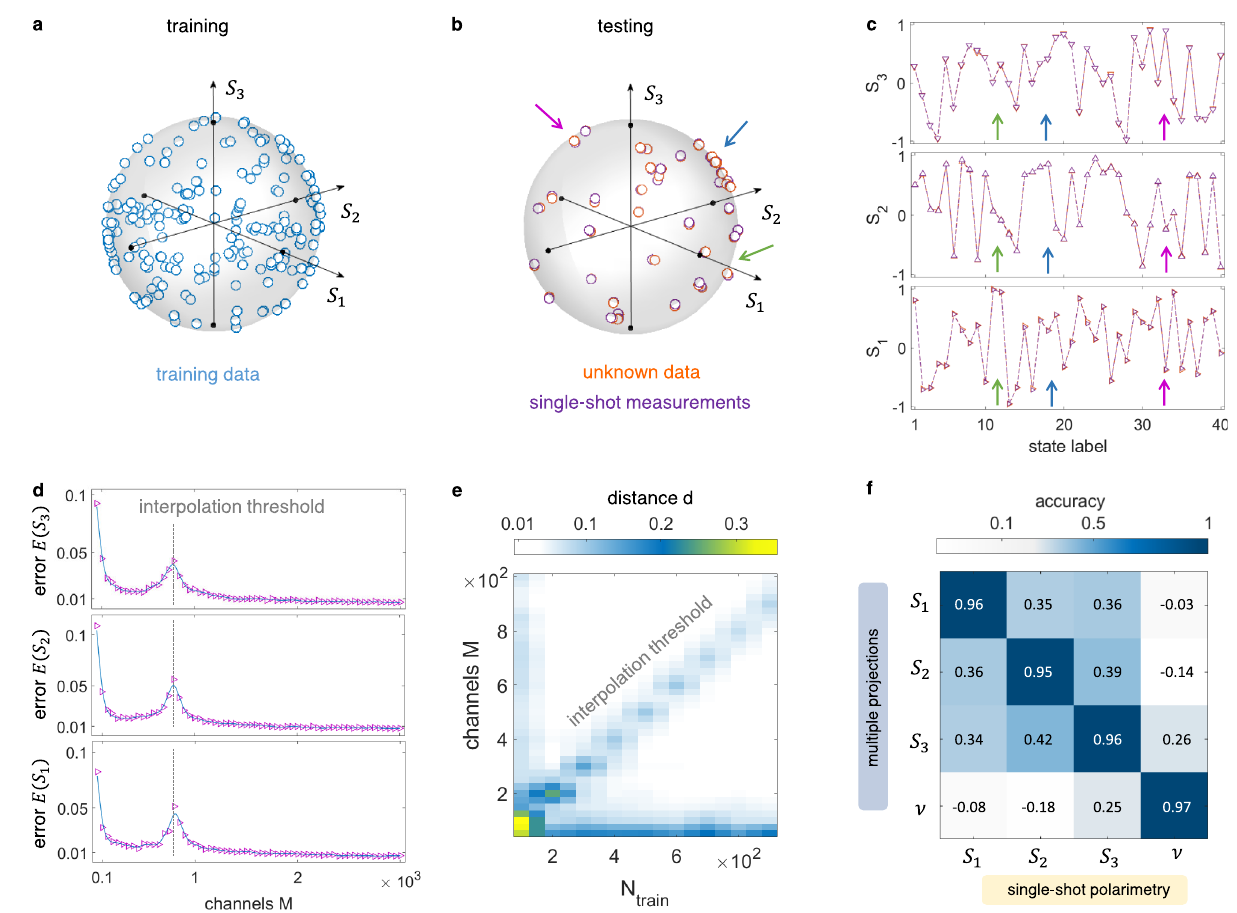
Fig. 3 | Polarization measurements by supervised learning. a Training dataset made by N train randomly-selected polarizations. b , c Measured SOP and corre- sponding Stokes parameters (purple), along with their unknown values used for testing(orange).Forclarity,onlyasubsetofsamplesisshown. d Testingerror E ( S i ) on each Stokes parameter versus the number of readout channels. The error peak